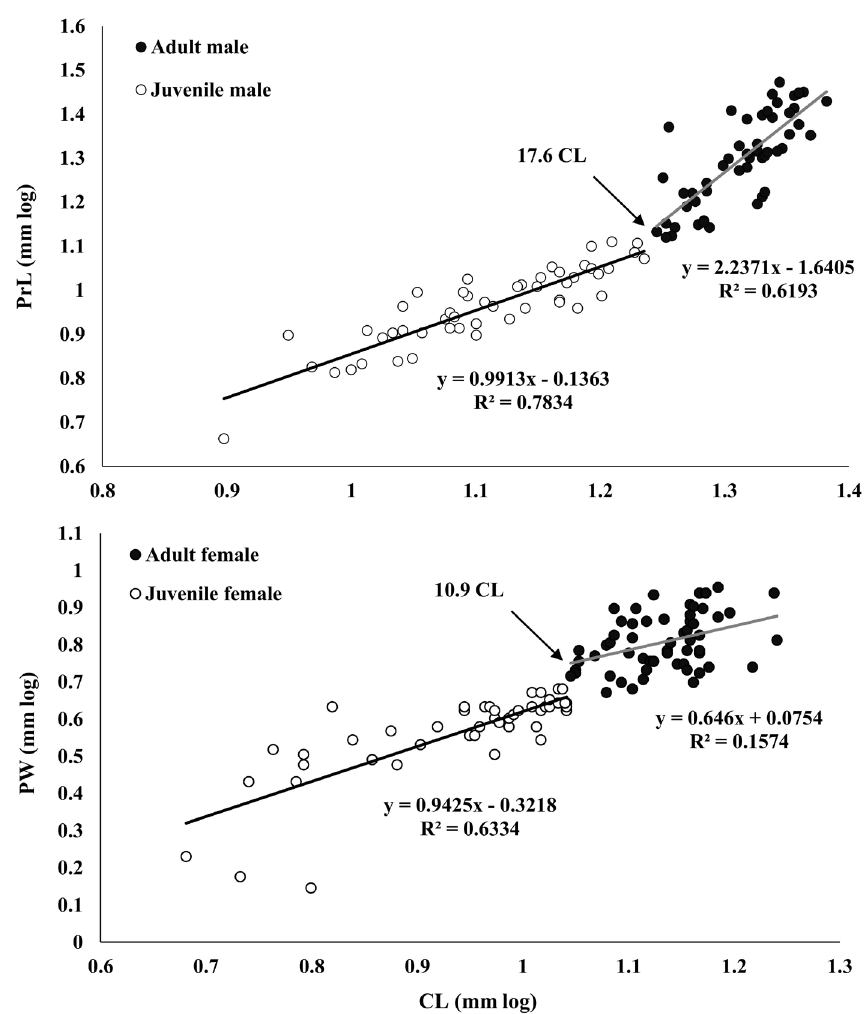
Figure 3. Macrobrachium candango Mantelatto, Pileggi, Pantaleão, Magalhães, Villalobos and Álvarez, 2021. Scatter plots of the selected morphometric relationships in males and females, highlighting the separation of groups (adults and juveniles). The arrows indicate the inflection break and the respective size estimated at the beginning of morphological sexual maturity, which corresponds to the CL of the smallest individual in the interruption of juvenile and adult equations, in relation to CL × PrL (males) and CL × PW (females). (CL) carapace length; (PrL) propodus length; (PW) pleura